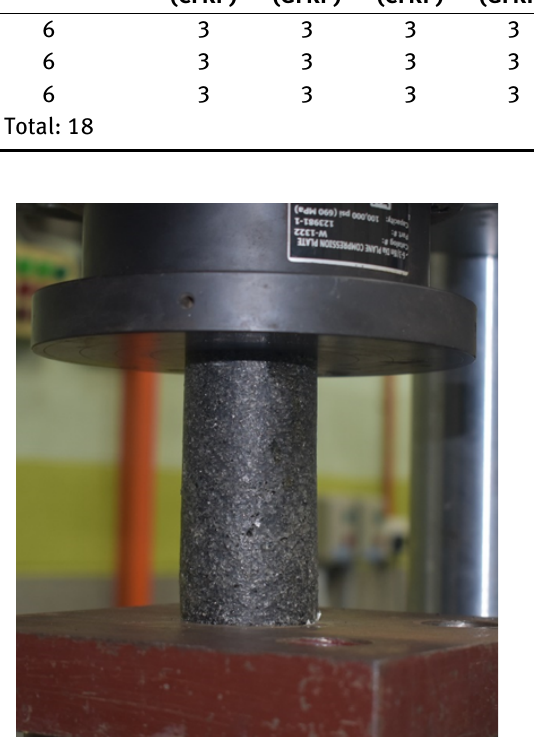
Figure 2: Compression testing of